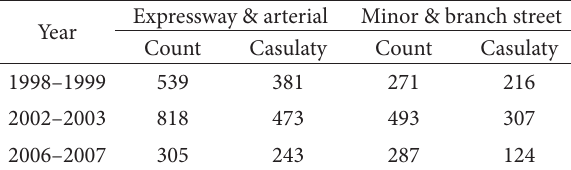
Table 1. Accident characteristics at three typical peaks